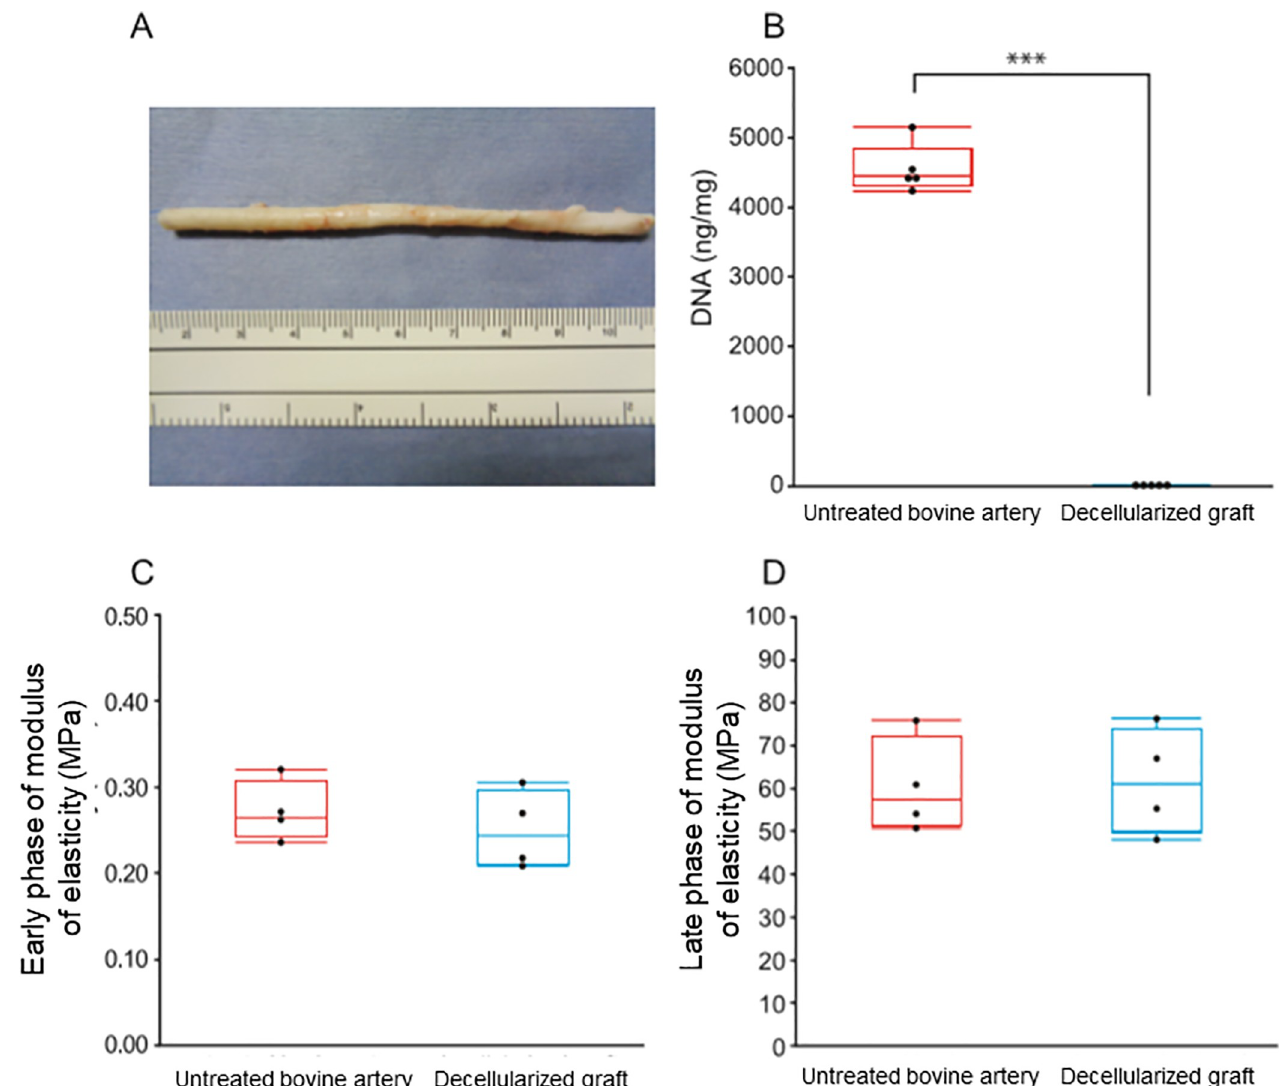
Fig 1. Characteristics of decellularized grafts with HHP method. ( A ) A representative macroscopic view of a decellularized bovine vessel with HHP method. HHP, high hydrostatic pressure. Upper scale of measure indicates centimeters, and lower indicates inchs, respectively. ( B ) Quantification of residual DNA. ��� P < 0.001. ( C ) Early phase of modulus of elasticity. ( D ) Late phase of modulus of elasticity.